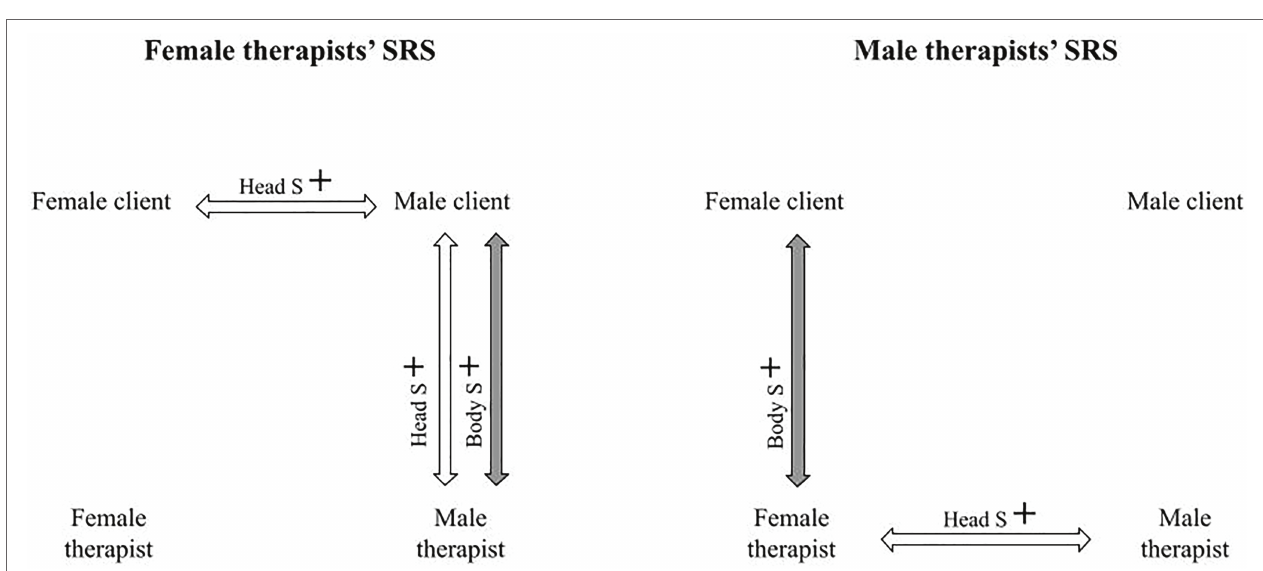
FIGURE 3 | The relationship between the female and male therapists’ alliance evaluations and the dyadic synchronies.